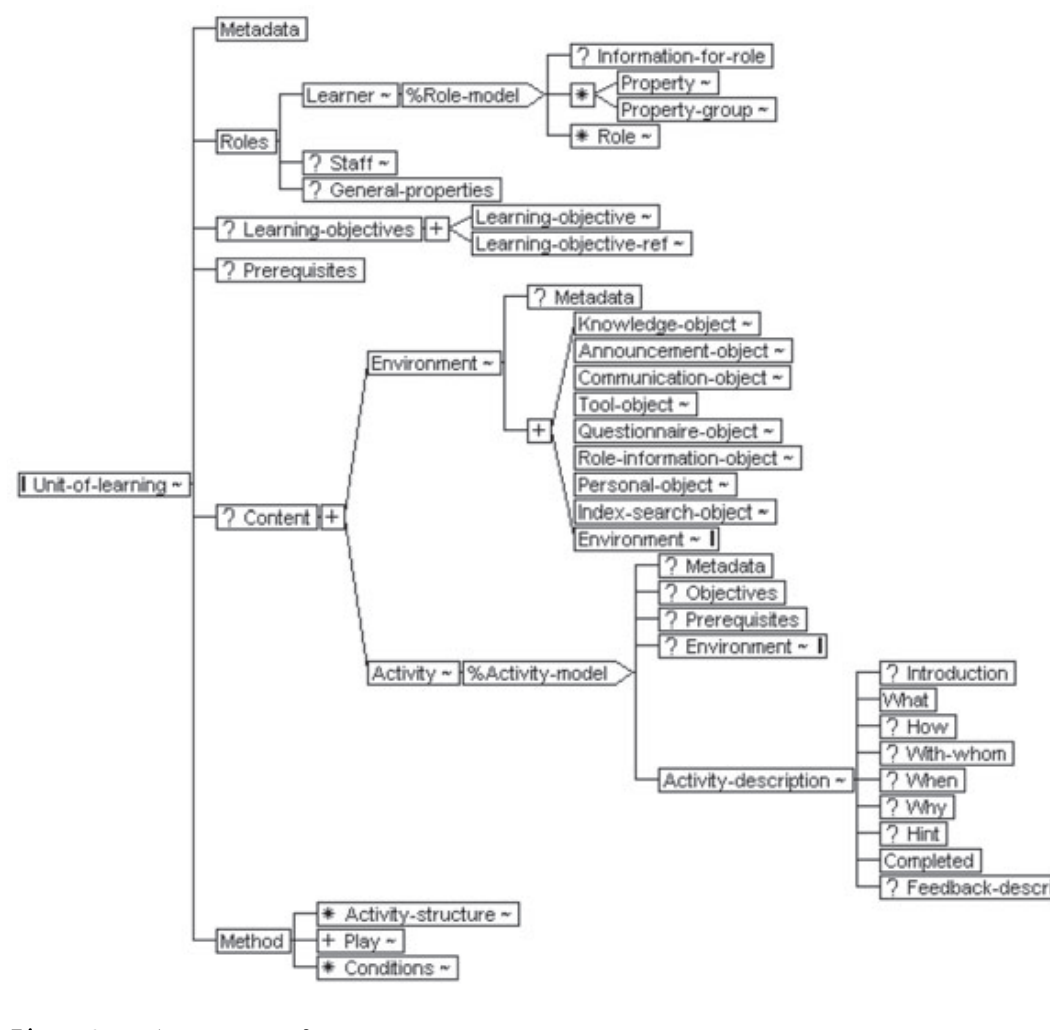
Figure 3 . Basic structure of IMS